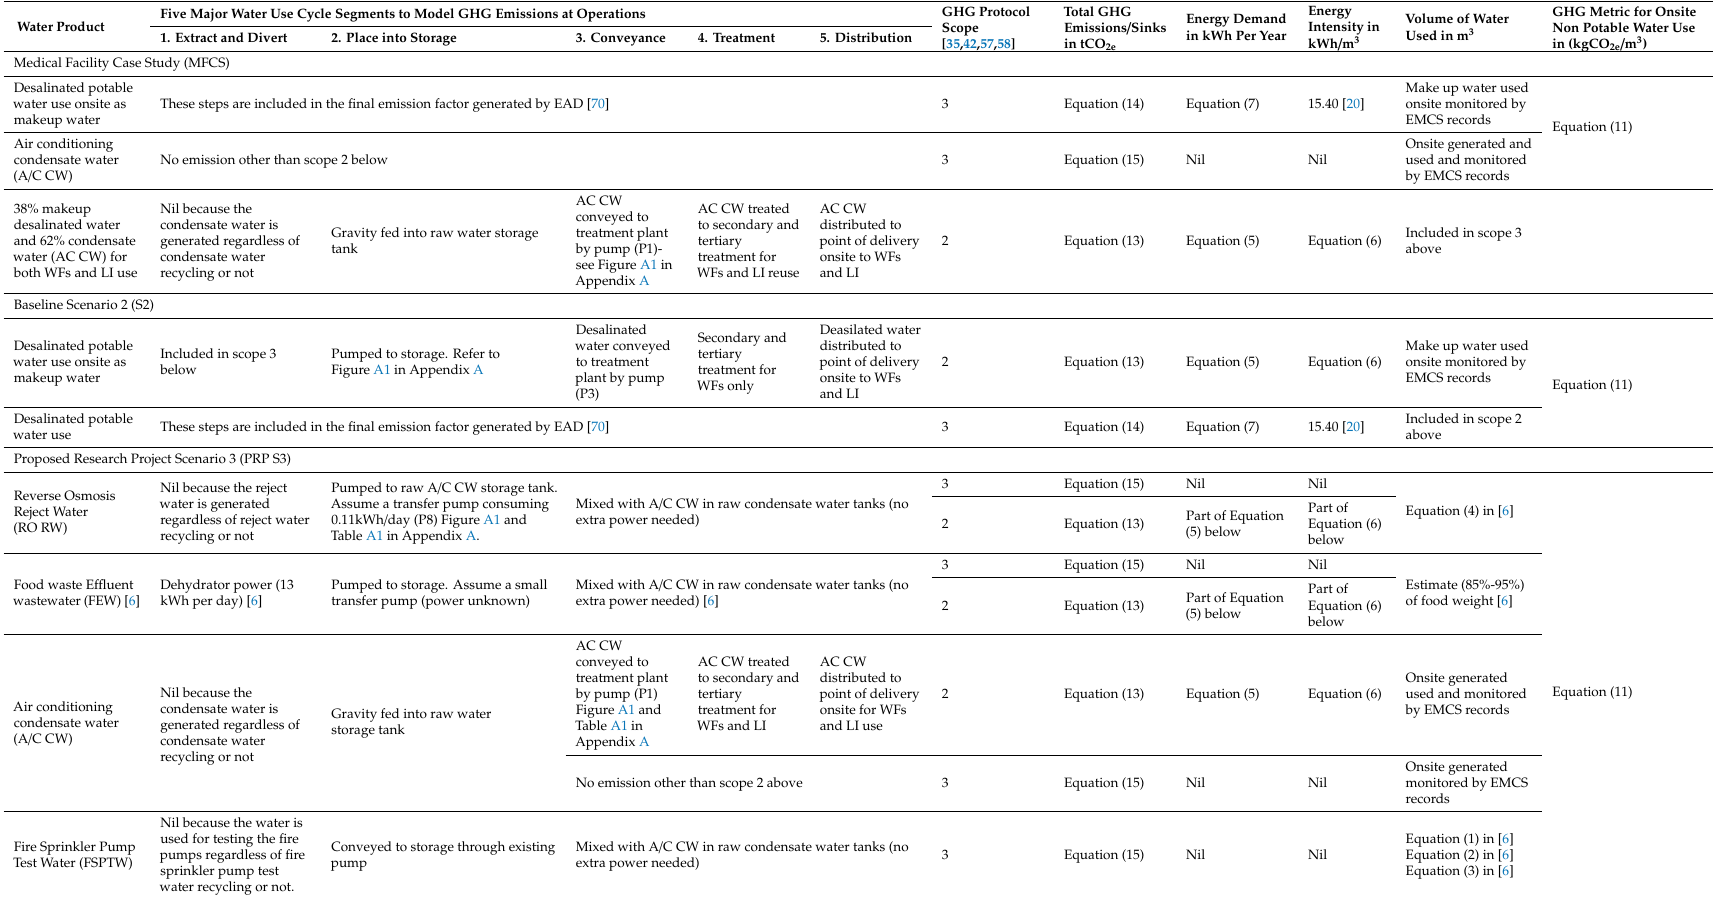
Table A2. MFCS non-potable water use cycle segments adapted from The Climate Registry